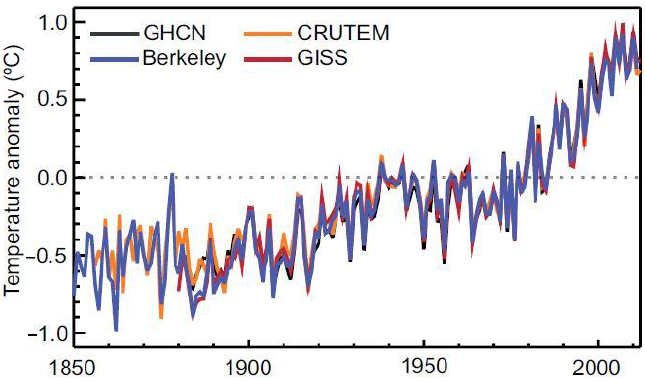
Figure 3. The global annual mean land-surface air temperature anomalies from the four datasets of Berkeley, CRUTEM, GHCN, and GISS, compared to the period of 1961–1990 (Source: IPCC report, 2013 [60]). Table 2. The seasonal temperature trends and the original Mann–Kendall test in the Kofarnihon River Basin, Central